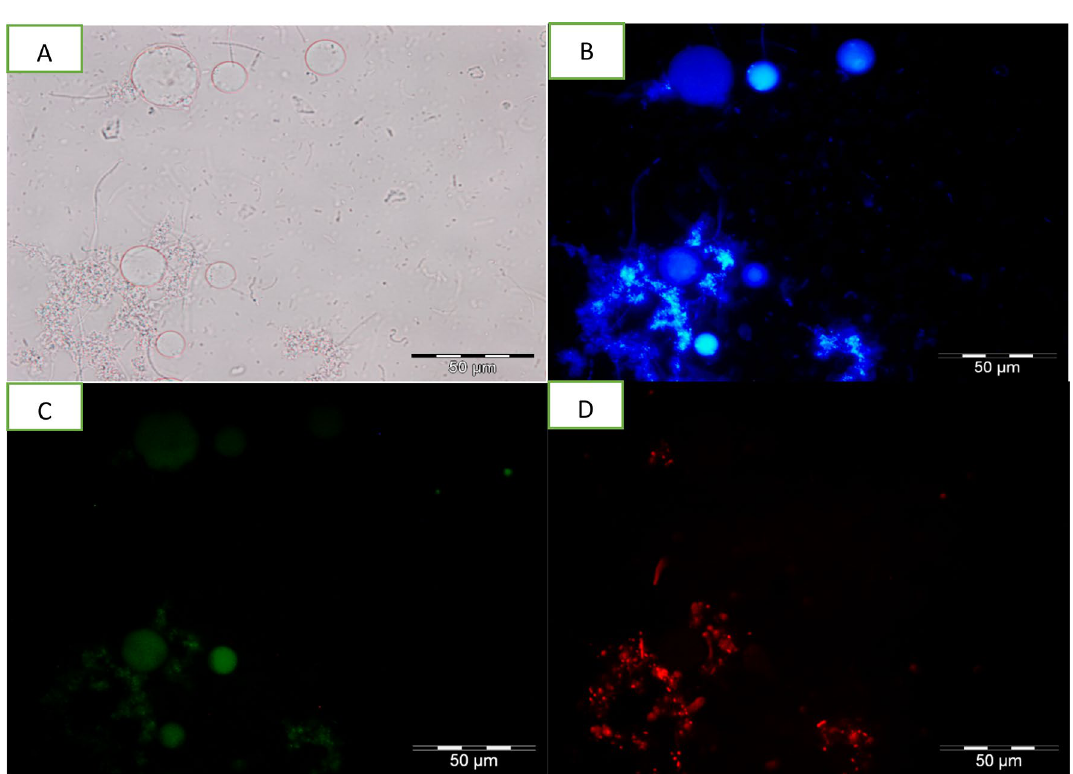
Figure 7. Images of TA treated (0.01 mg/ml) Blastocystis sp. undergoing apoptosis viewed under epifluorescent microscope; ( A ) Bright field; ( B ) stained using Hoechst stain; ( C ) [stained using FITC Annexin (V); ( D ) stained using Propidium